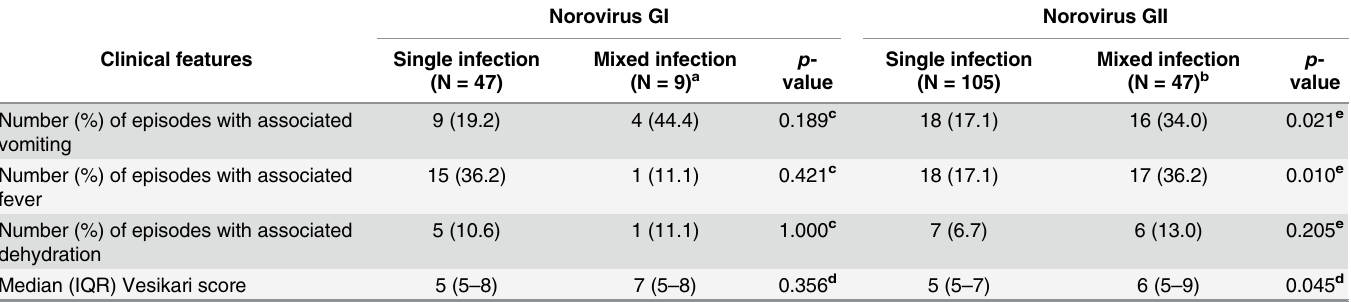
Table 3. Comparison of clinical features between diarrheal episodes of single infections with norovirus and mixed infections of norovirus and other enteric